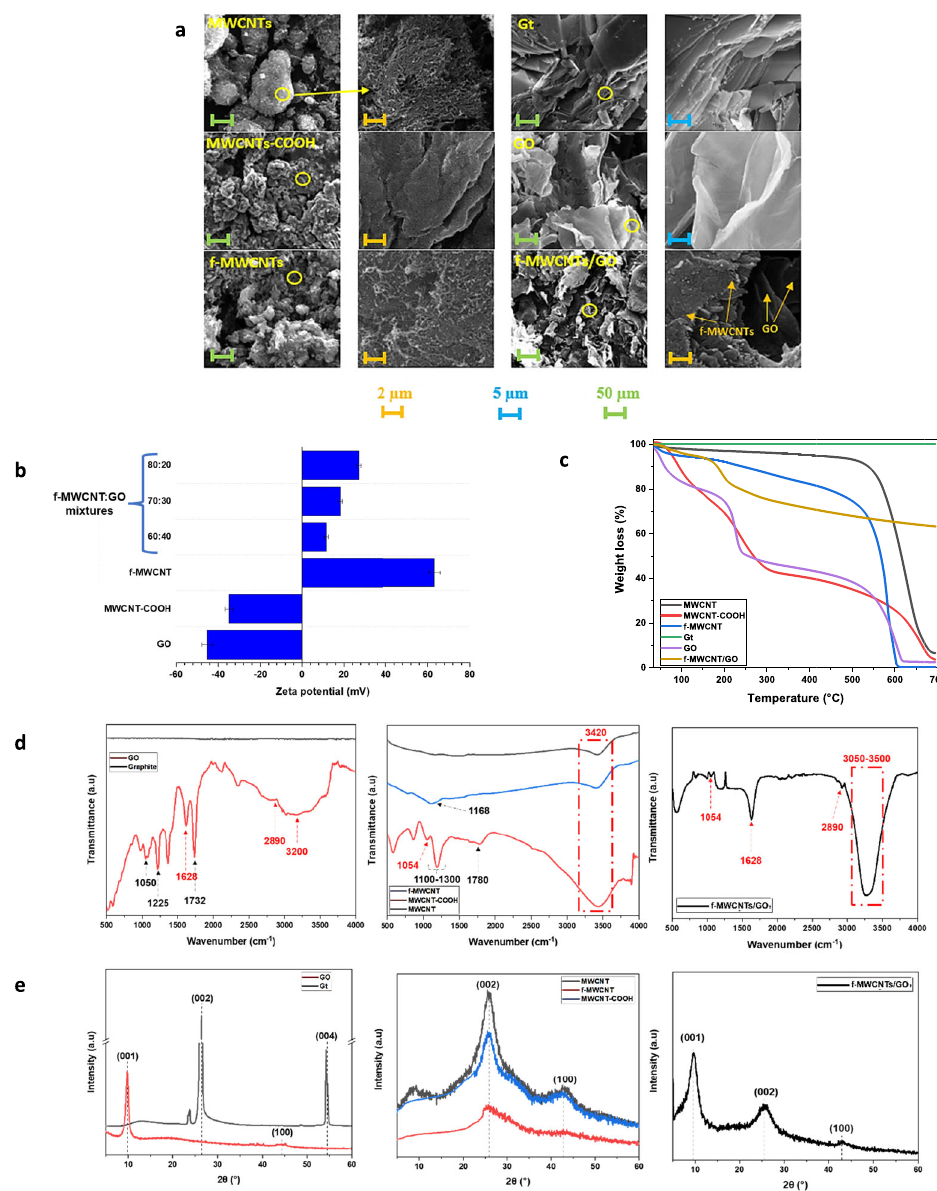
Fig. 1 Nanomaterial characterization. a SEM images of prepared nanomaterials. b Zeta potential measurements of the fabricated nanohybrids with different ratios. c TGA curves of the fabricated nanomaterials. d FTIR spectrum of fabricated nanomaterials. e XRD patterns of fabricated